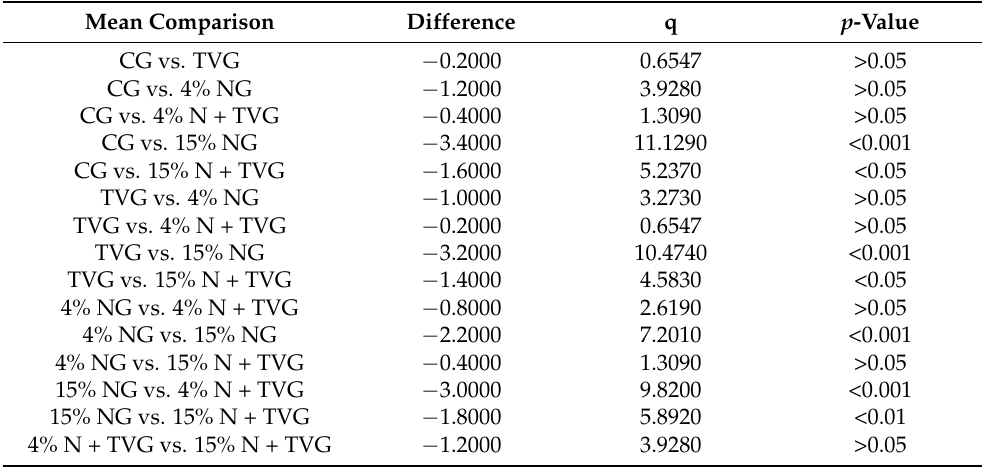
Table 3. Statistical analysis of biochemical results between groups.